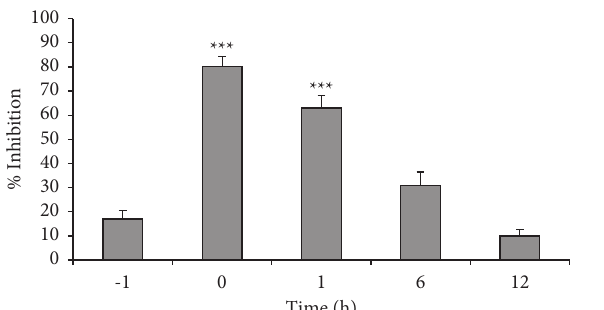
Figure 3: Time-dependent inhibition of polyphenon-60 on the replication cycle of the NDV B1 strain. Data were expressed as the mean ± SD of three independent experiments and compared by using Student’s t -tests. ∗∗∗ Highly statistically significant ( p < 0 .